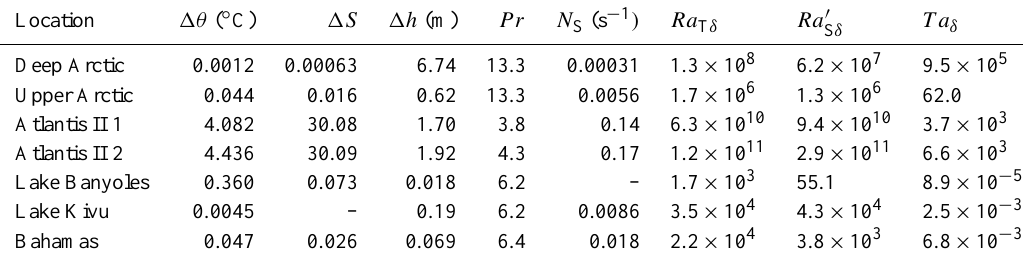
, of the S δ T a δ S δ